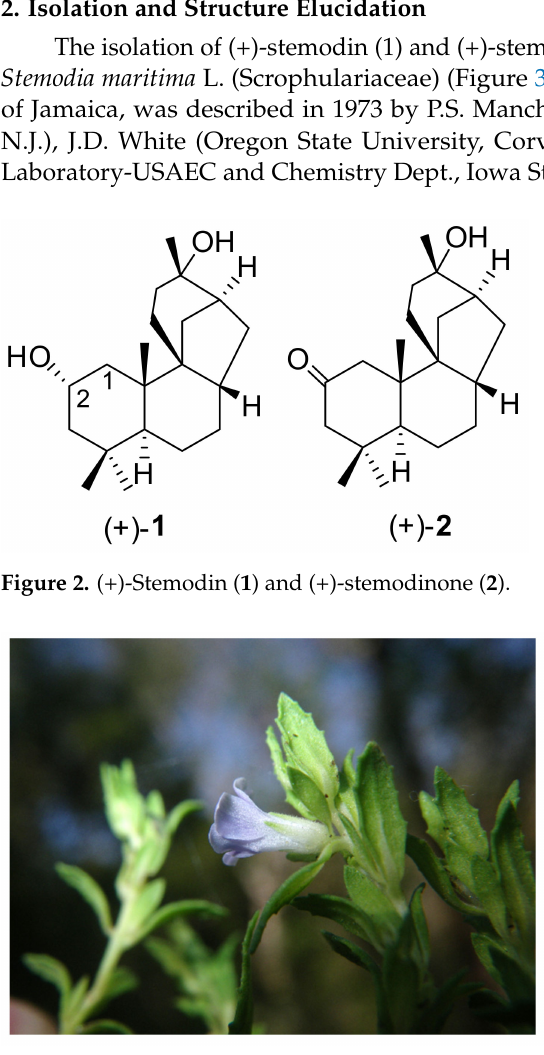
Figure 3. Stemodia maritima (Scrophulariaceae).